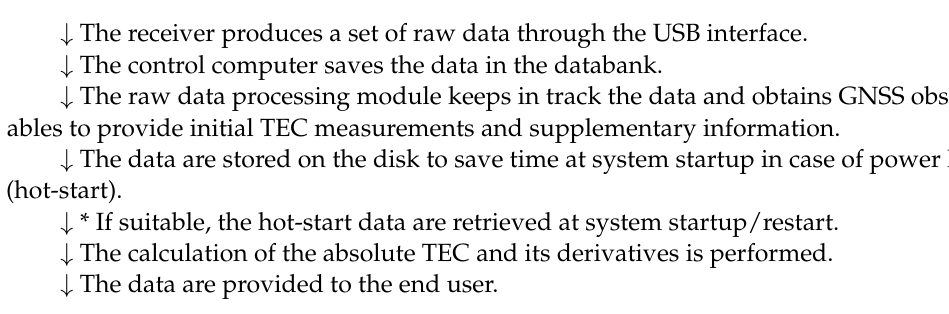
Figure 4. Data diagram for the suite to monitor the ionospheric TEC.